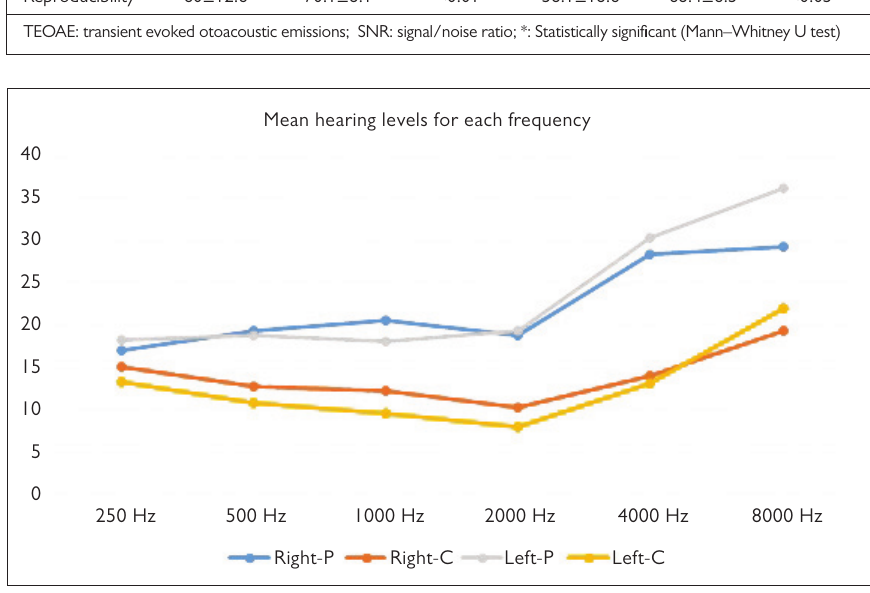
Figure 1. Audiological results of OSAS and